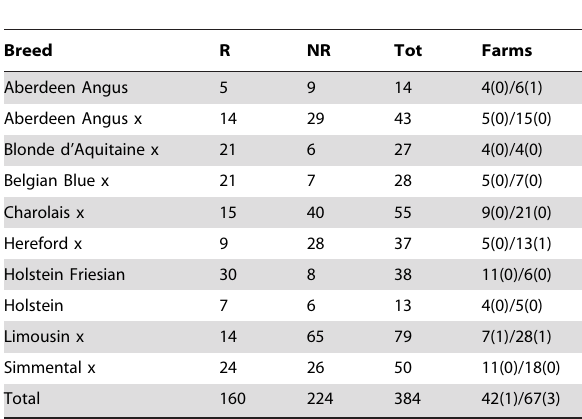
Table 1. Numbers of samples used in this study, classified by breed and reactor